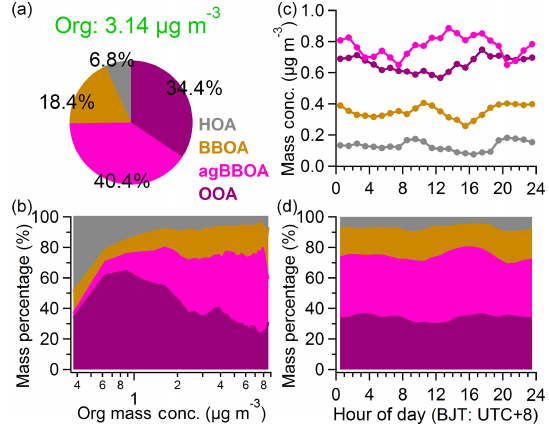
Figure 6. The average mass contributions of four organic compo- nents to total organics (a) during the entire study period and (b) as a function of total organics mass concentrations, as well as the diur- nal variations of (c) mass concentrations and (d) mass contributions of four organic components in this